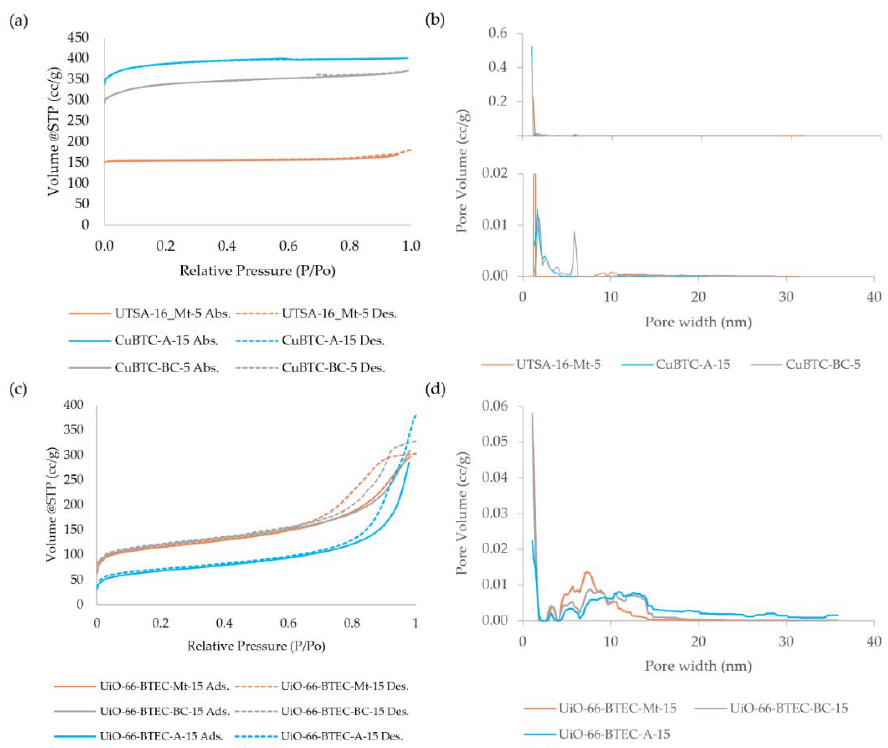
Figure 5. N 2 adsorption–desorption isotherms of ( a ) CuBTC-A-15, CuBTC-BC-5, UTSA-16-Mt-5 and ( c ) UiO-66-BTEC-BC-15, UiO-66-BTEC-Mt-15, UiO-66-BTEC-A-15; pore size distribution of ( b ) CuBTC-A-15, CuBTC-BC-5, UTSA-16-Mt-5 and ( d ) UiO-66-BTEC-BC-15, UiO-66-BTEC-Mt-15, UiO-66-BTEC-A-15.